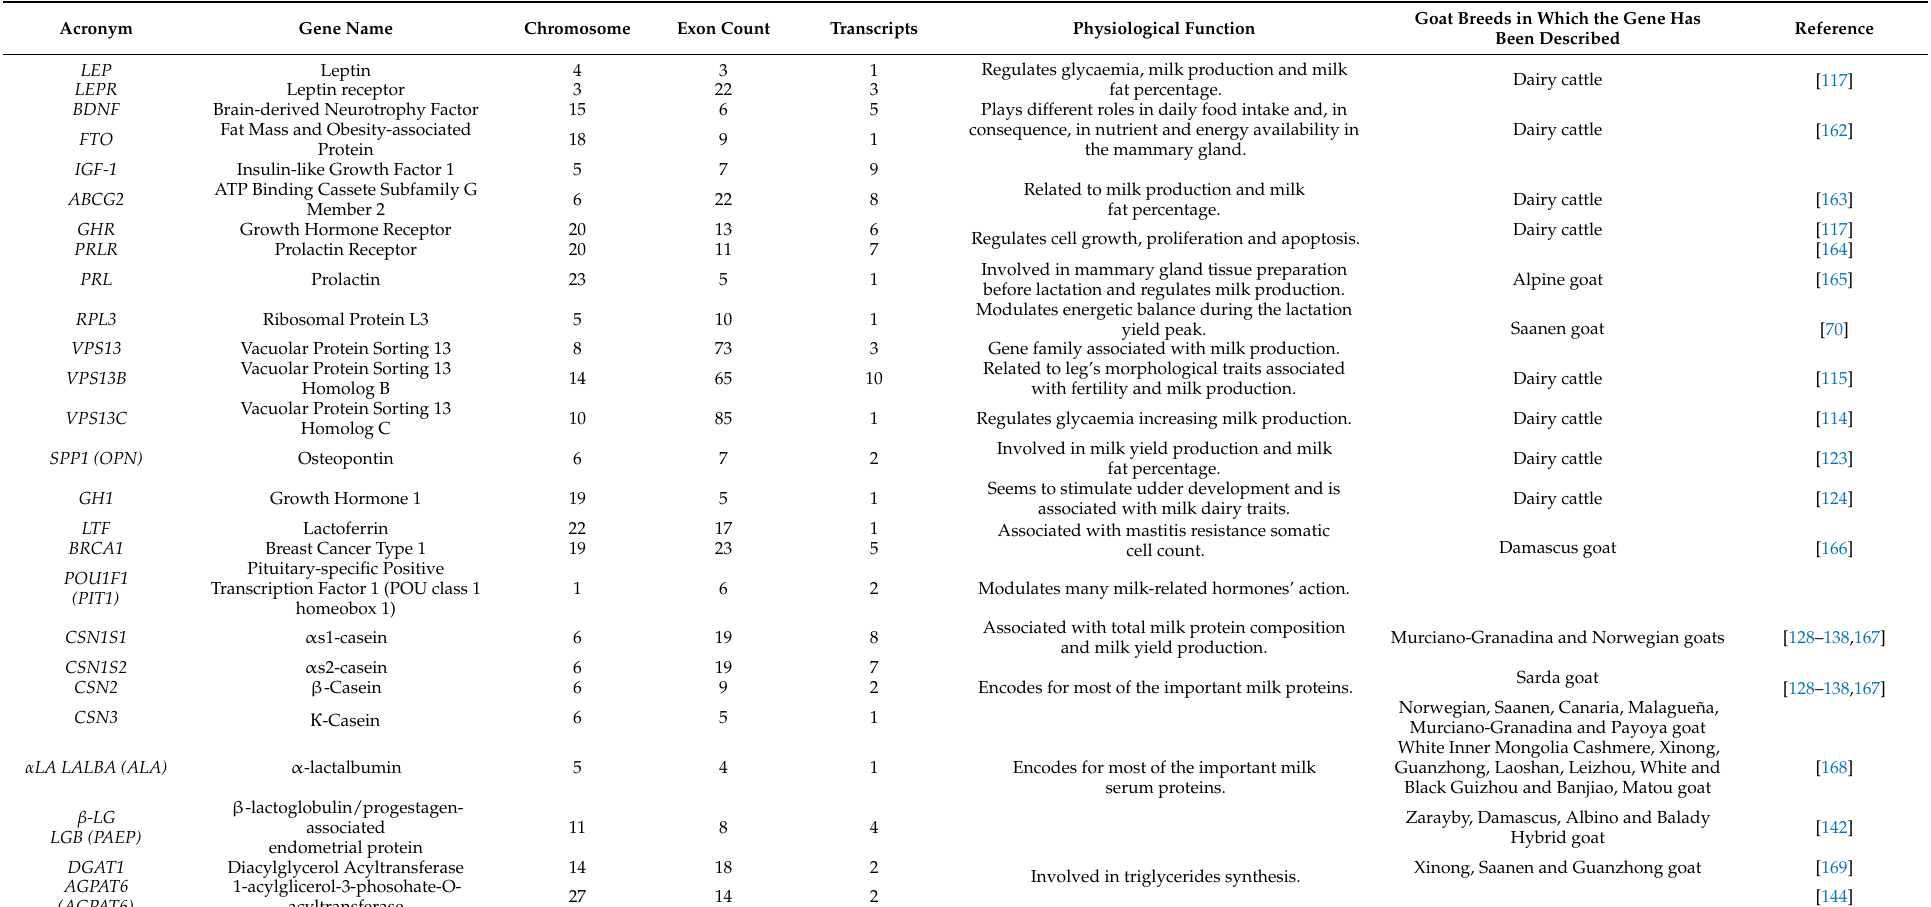
Table 5. Summary of the candidate genes associated with milk production/yield that have been described in goat breeds, their chromosome location, exon counts, physiological function and where to find them in the literature.